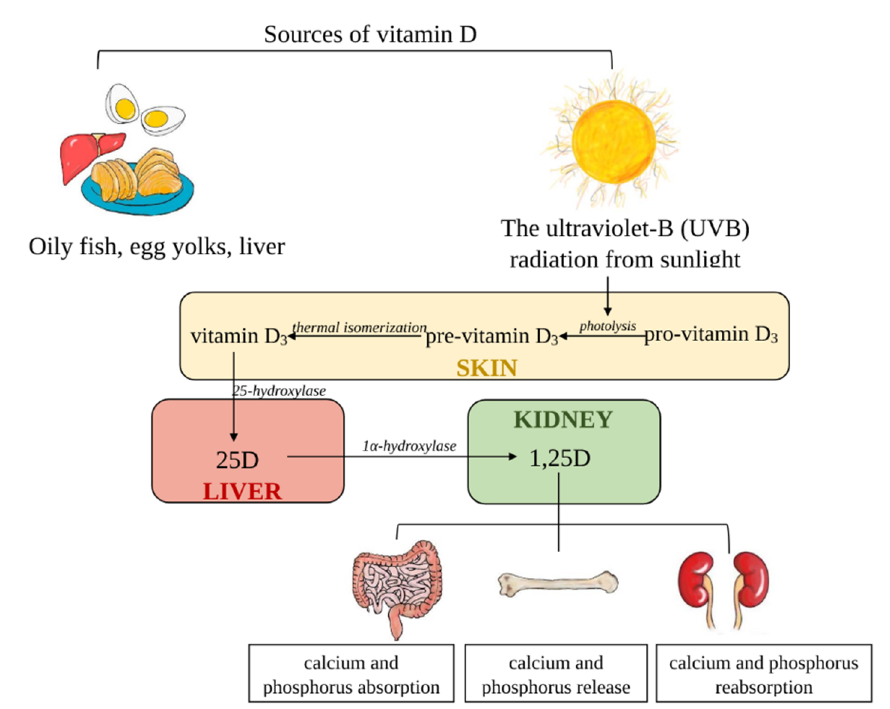
Figure 3. Vitamin D sources, metabolism, and role in calcium homeostasis. Abbreviations: 25D, 25-hydroxycholecalciferol; 1,25D, 1,25-dihydroxycholecalciferol.